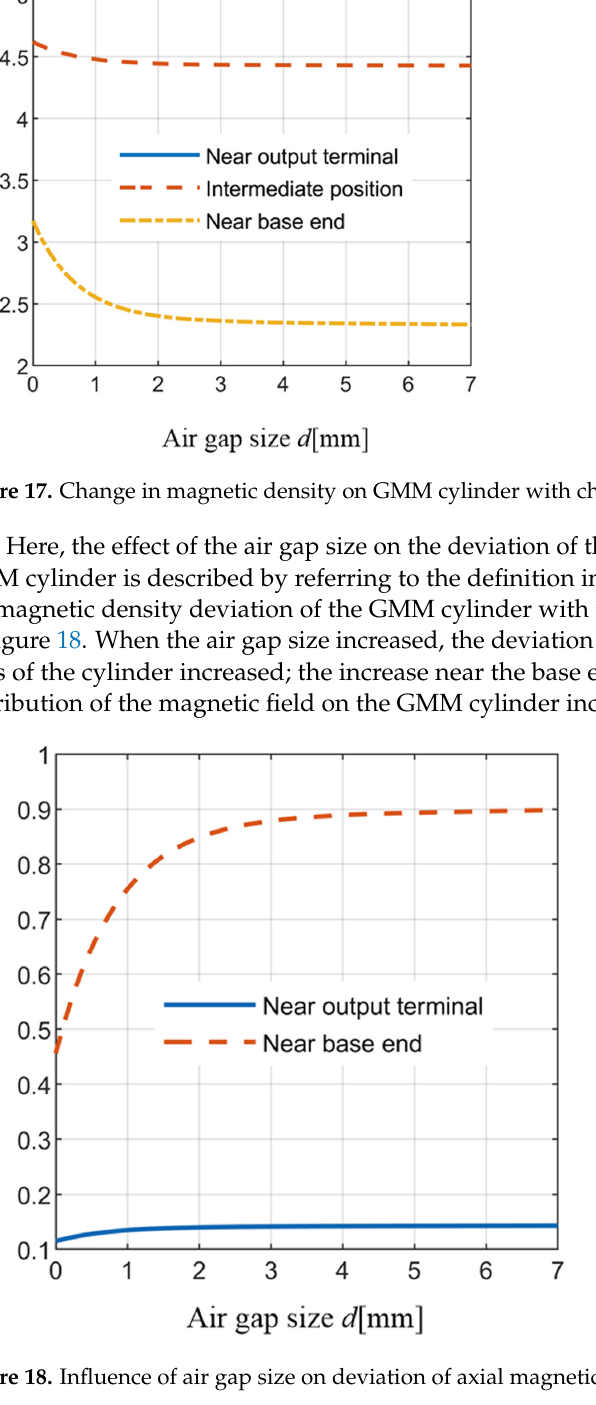
Figure 16. The axial magnetic density distribution of the GMM cylinder by changing the air gap size.